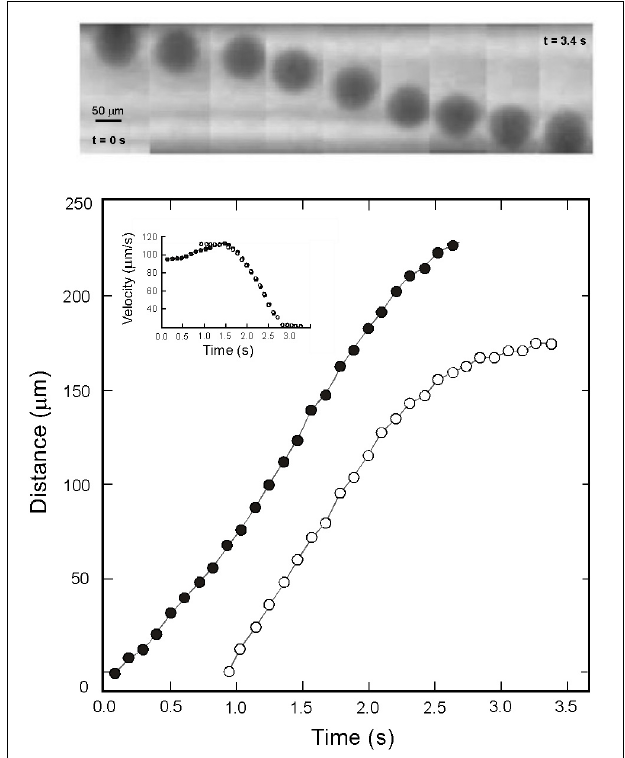
FIGURE 4 | (Top) Radiographic images of a falling Rhenium sphere from sample B2 at 2.4 GPa – 1906 K and (Bottom) the corresponding distance vs. time plot. The location of the top and bottom points of the sphere, represented as open and filled symbols respectively, were tracked on each individual frame using the Metavue R (cid:13) image software. The goal of using both the top and bottom points of the sphere rather than its centroid is to increase the fall length measurement. The inset shows the derived falling velocities for this experiment. The achievement of a plateau at 111 ± 6 µ m/s is a good indication that the sphere reached its terminal settling velocity.